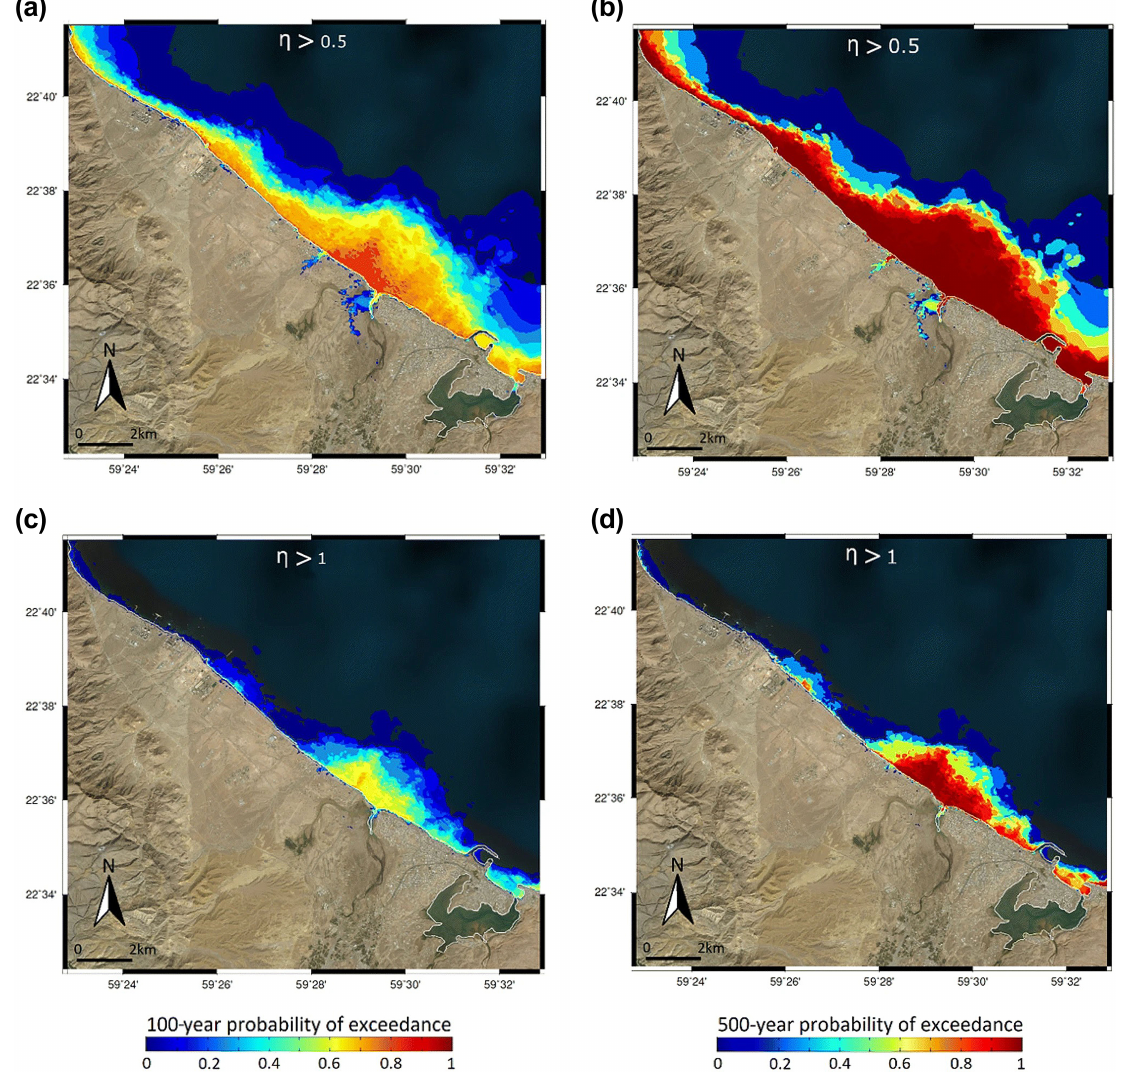
Figure 10. Probability of tsunami wave height/flow depth exceeding 0.5 m ( a , b ) and 1 m ( c , d ) for time periods of 100 (left panel) and 500 (right panel) years along the coastline of Sur, Oman